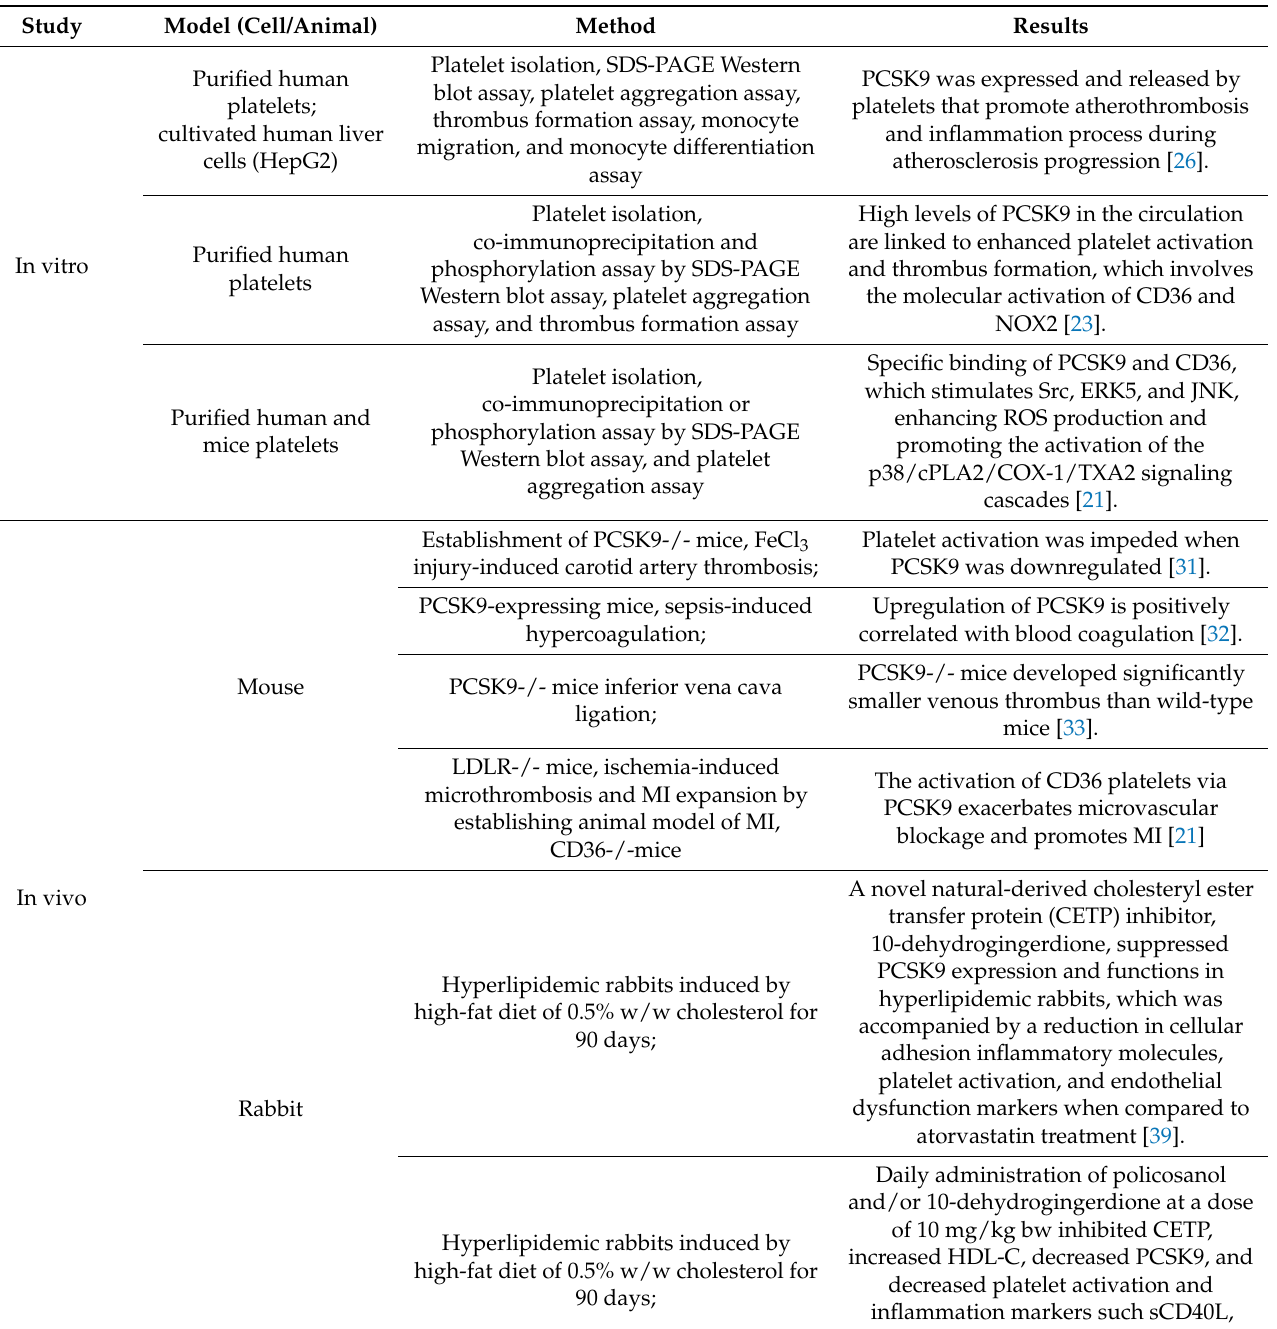
Table 1. The experimental models used to study PCSK9-induced platelet activation in cardiovascular disease